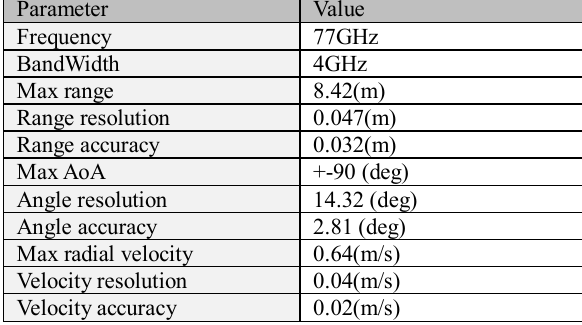
Table 1. The radar parameters in this